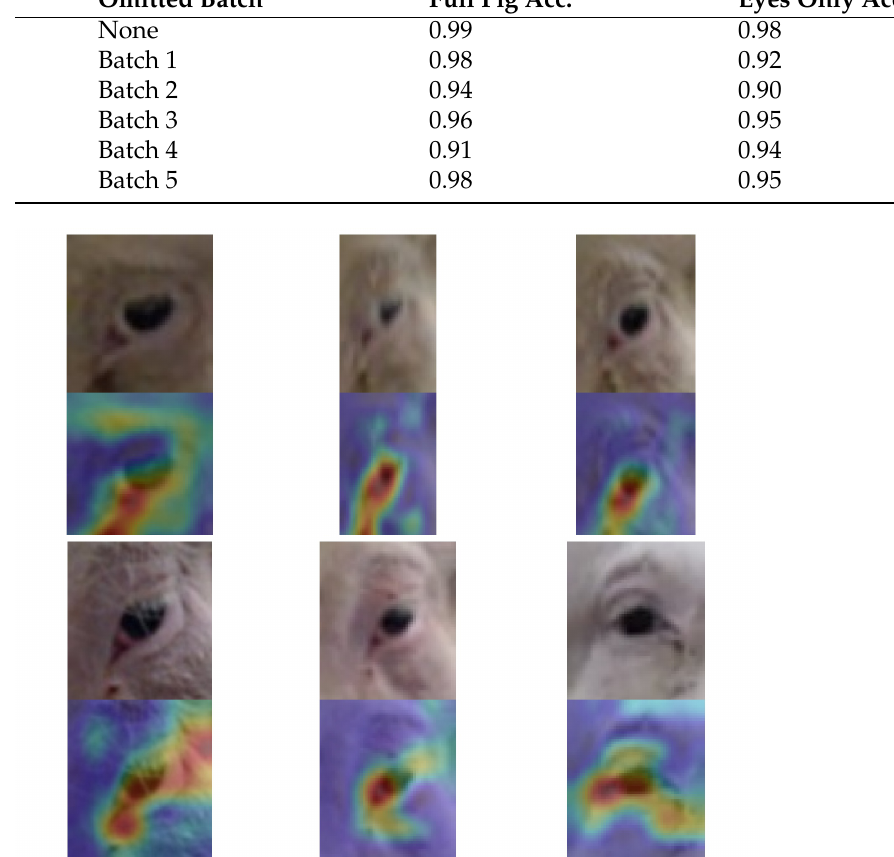
Table 4. Table comparing the accuracy of the whole pig image (i.e., those used in the previous experiments) with only the eye regions to see how much contribution to prediction accuracy comes from such a small region. It can be seen that whilst not as accurate as using the full image of the pig, the eyes do significantly contribute to being able to determine whether pigs are stressed or unstressed. Full Pig Acc. Eyes Only Acc.